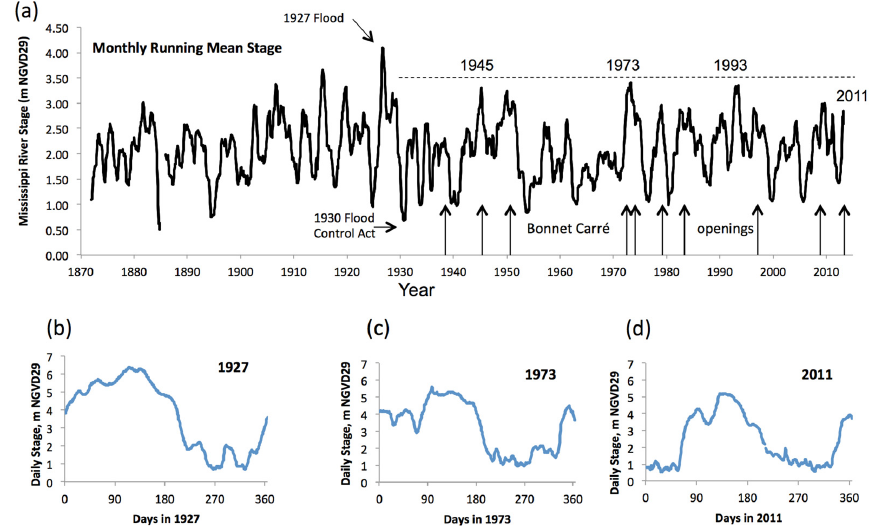
Figure 1. A monthly running mean of daily stage (m, NGVD29) at the Carrollton gauge, New Orleans, Louisiana, is shown from 1871 to 2011 for the Mississippi River ( a ); the 1927 flood was the highest recorded stage on the river in 132 years, exceeding the next highest stage in 1916 by over half a meter. Daily stage is shown for 1927 ( b ), 1973 ( c ), and 2011 ( d ) to illustrate the duration and variability in flood crest heights and timing for major flood years. After the implementation of flood control plans, the river never again crested as high as the 1927 flood.